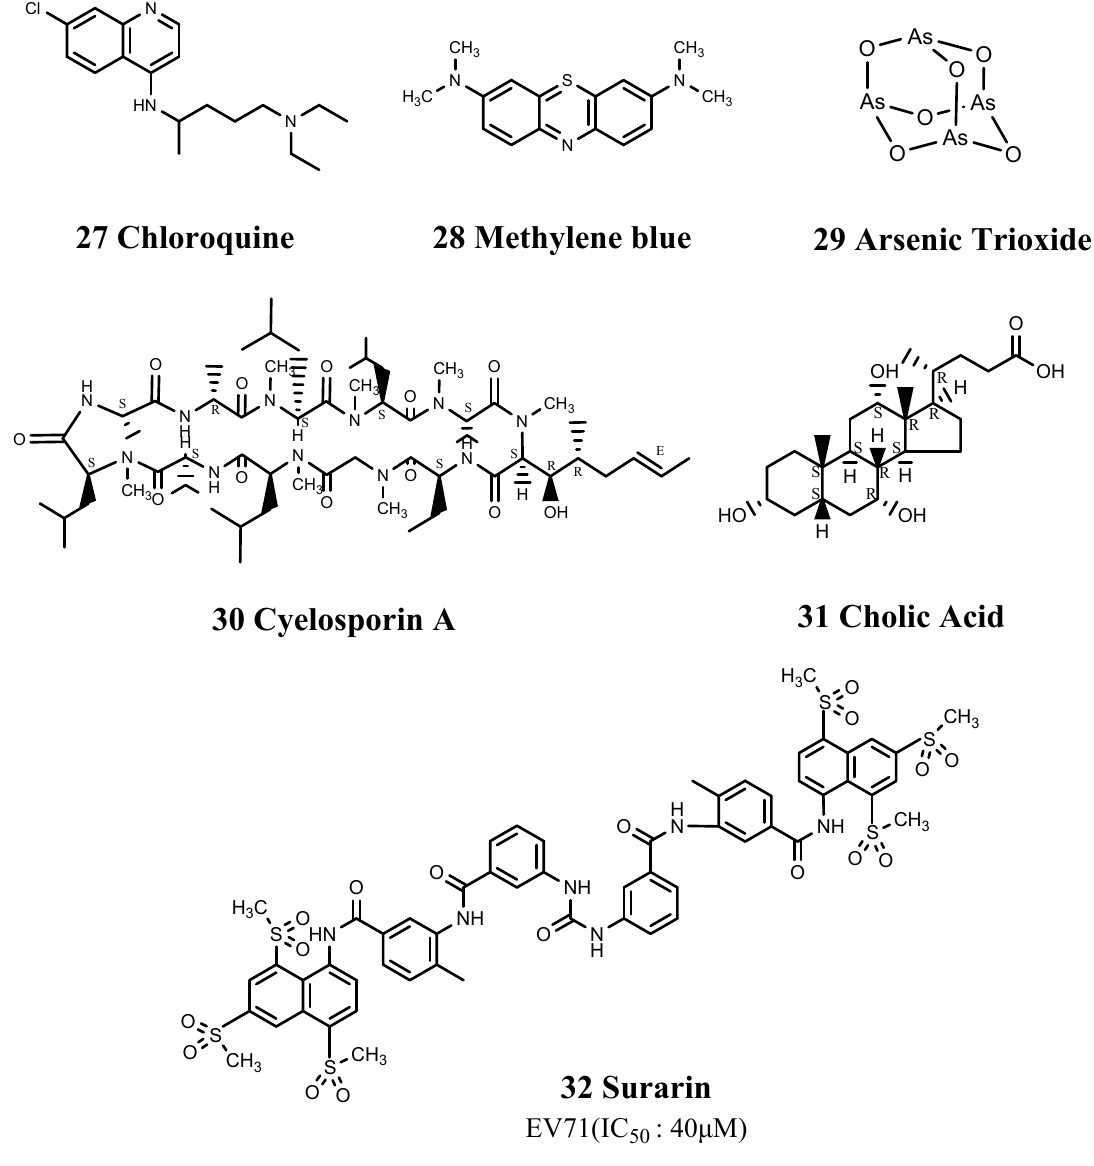
Figure 8. Structures of other drugs.